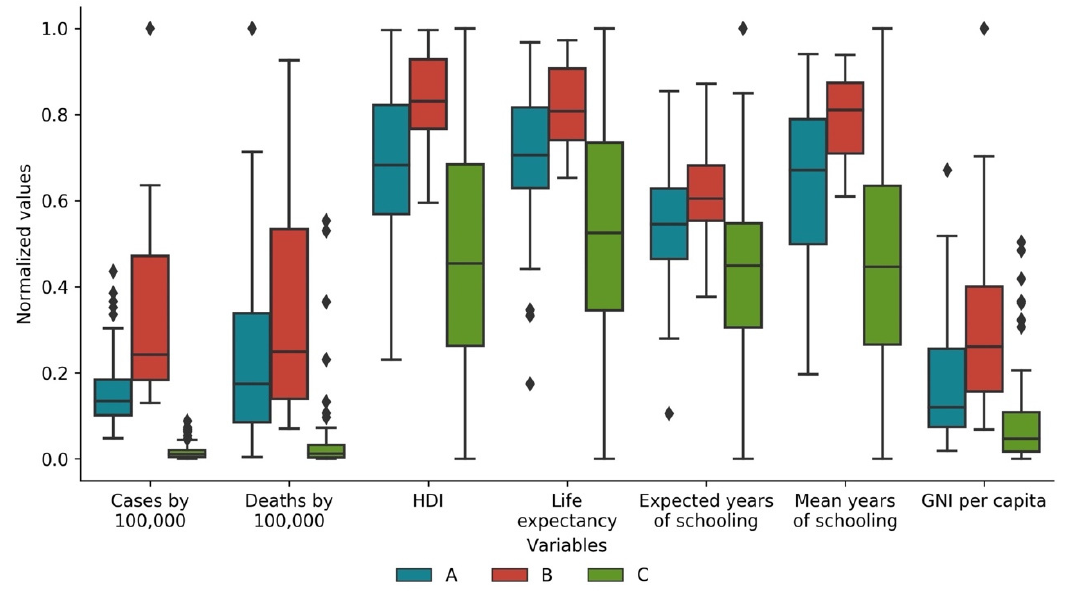
Figure 17. Boxplots of variables per cluster of cases at Day 250 (excluding the 24 countries/territories that are not present in the UNDP dataset) (HDI, Human Development Index; GNI, Gross National Income).